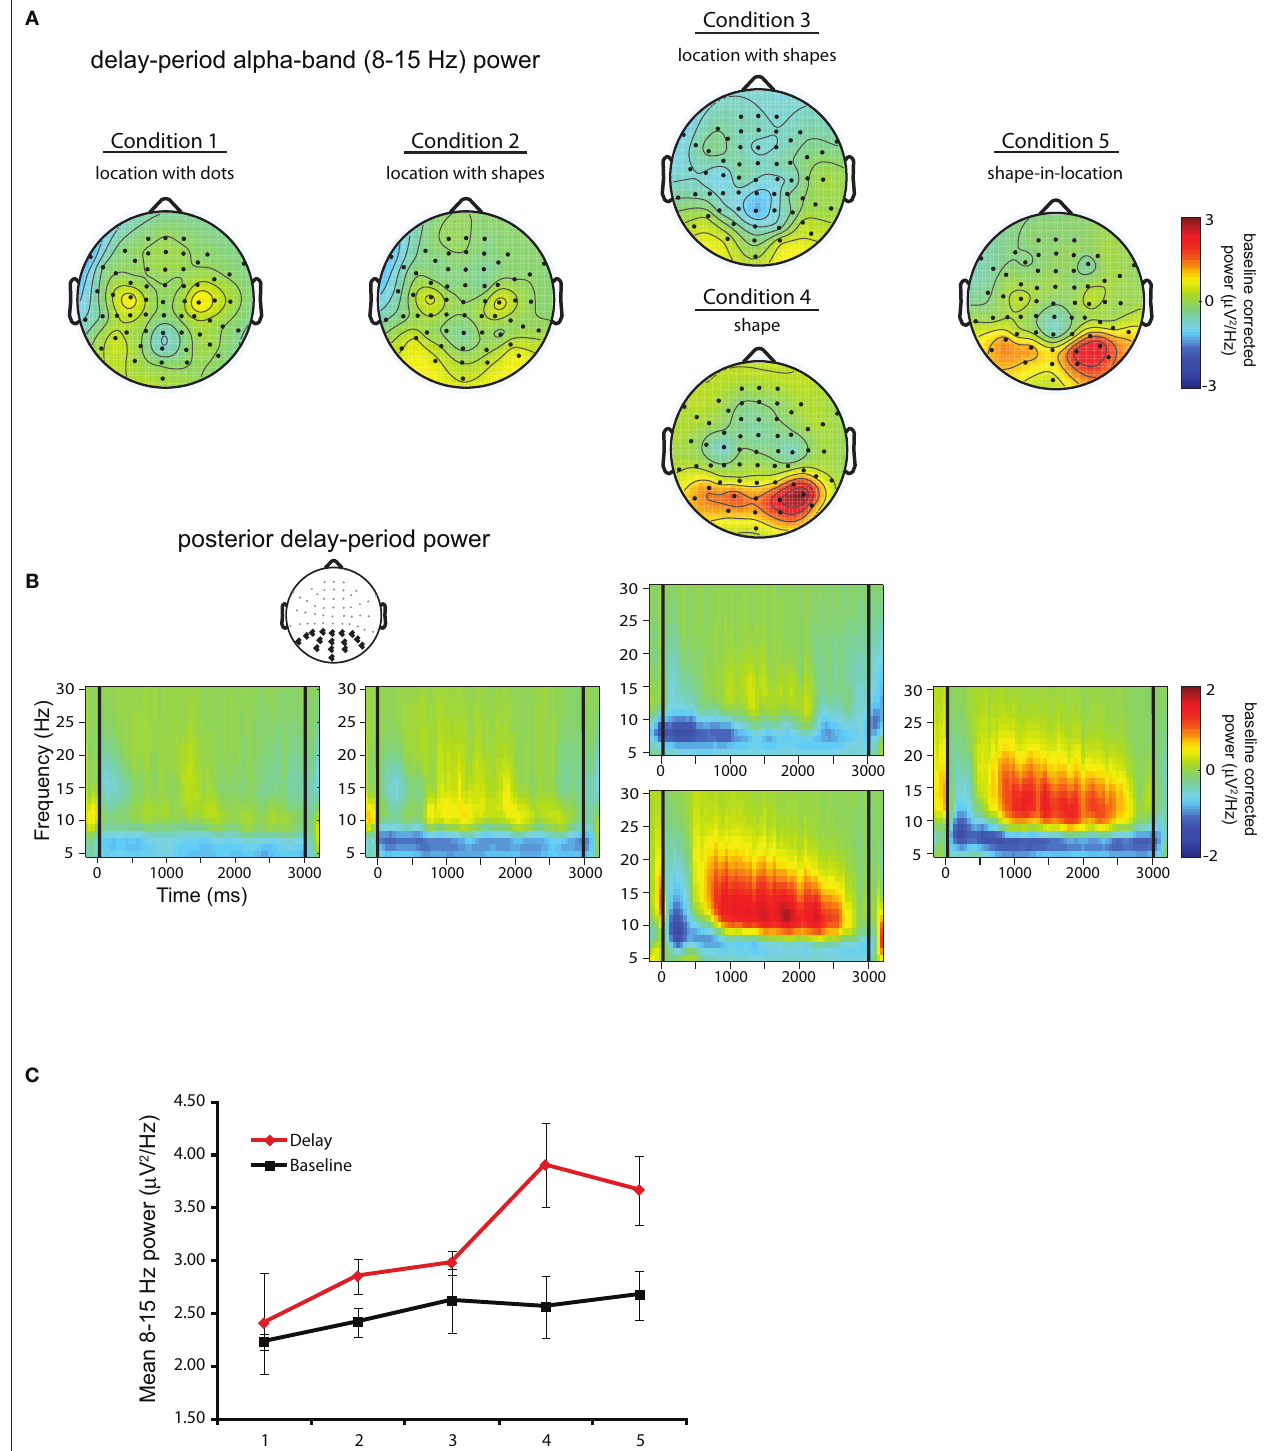
Figure 3 | Delay-period alpha-band power. (A) Topographical plots of mean power in the 8- to 15-Hz frequency band averaged over the 500- to 2500-ms portion of the delay across each block/condition. (B) Time–frequency plots for each trial block across the full delay period (delay marked by black lines at 0 and